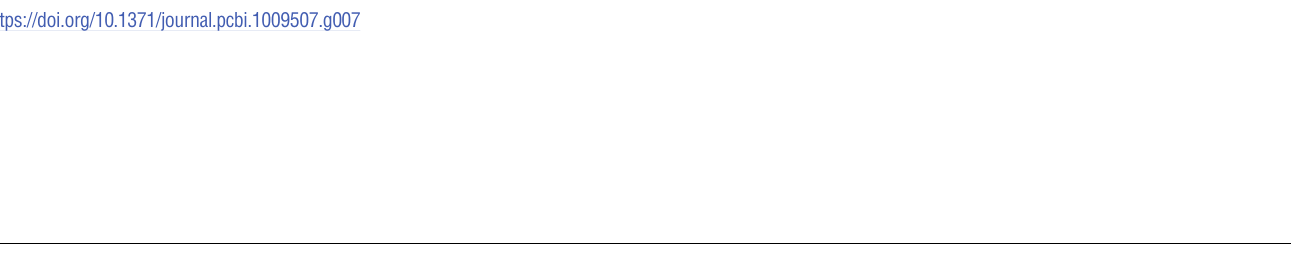
PLOS Computational Biology | https://doi.org/10.1371/journal.pcbi.1009507 October 13,